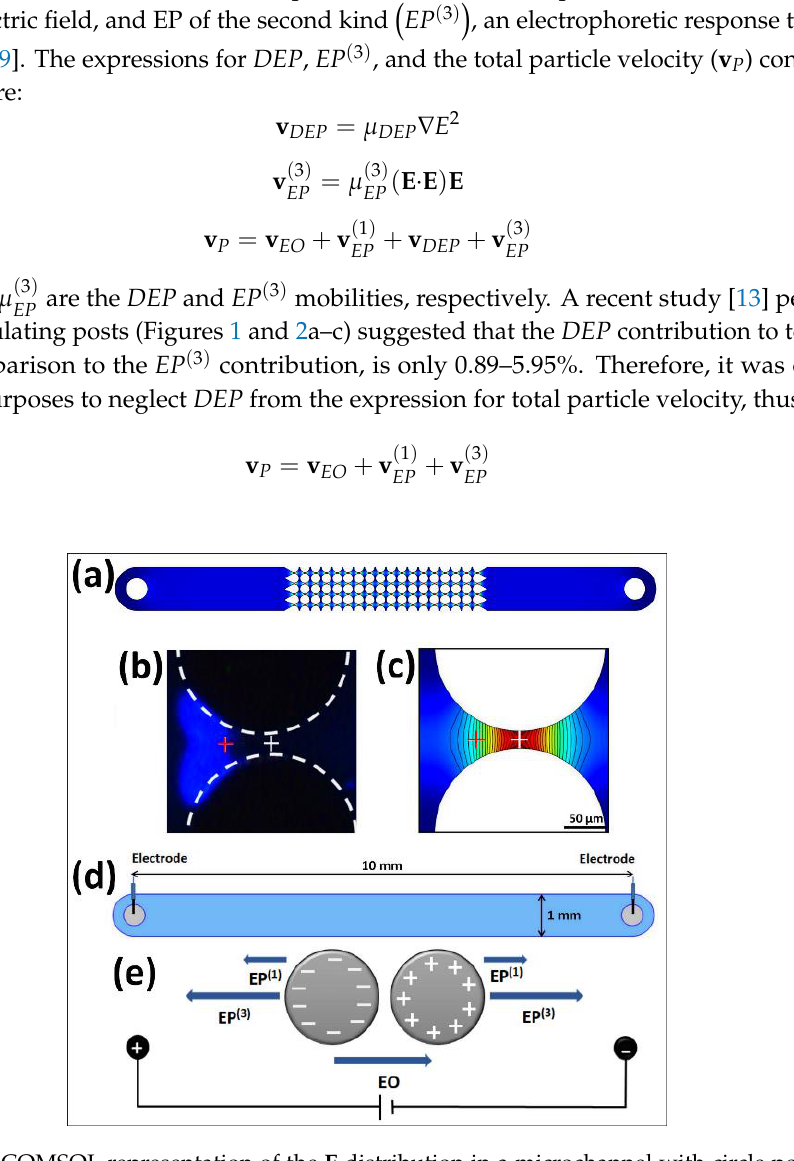
Figure 2. ( a ) COMSOL representation of the E distribution in a microchannel with circle posts. ( b ) Experimental image of E. coli cells trapping at 1000 V between two circle-shaped posts. ( c ) Distribution of E within the constriction region at 1000 V, where red represents the highest E magnitude. The black contour lines are isometric lines across which E is uniform, the red cross represents where the new method would estimate the empirical electrokinetic equilibrium condition ( eE EEC ), and the white cross represents where the preliminary study [13] estimated the eE EEC . ( d ) Schematic representation of post-less channel employed in the estimation of E EEC using particle velocimetry measurements [40]. ( e ) Forces acting on particles in post-less channels depending on their surface charges.